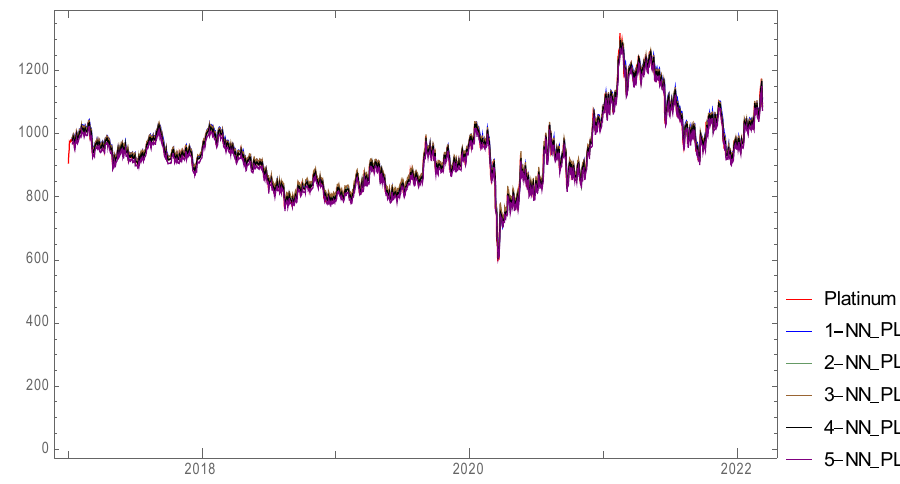
Figure 6. The current trend of platinum price in USD and smoothed time series.